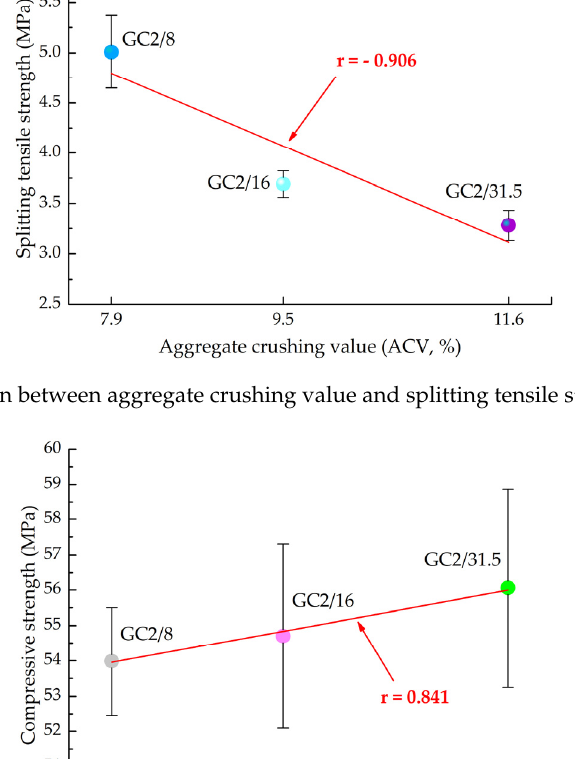
Figure 5. Correlation between aggregate crushing value and elastic modulus E of concrete.